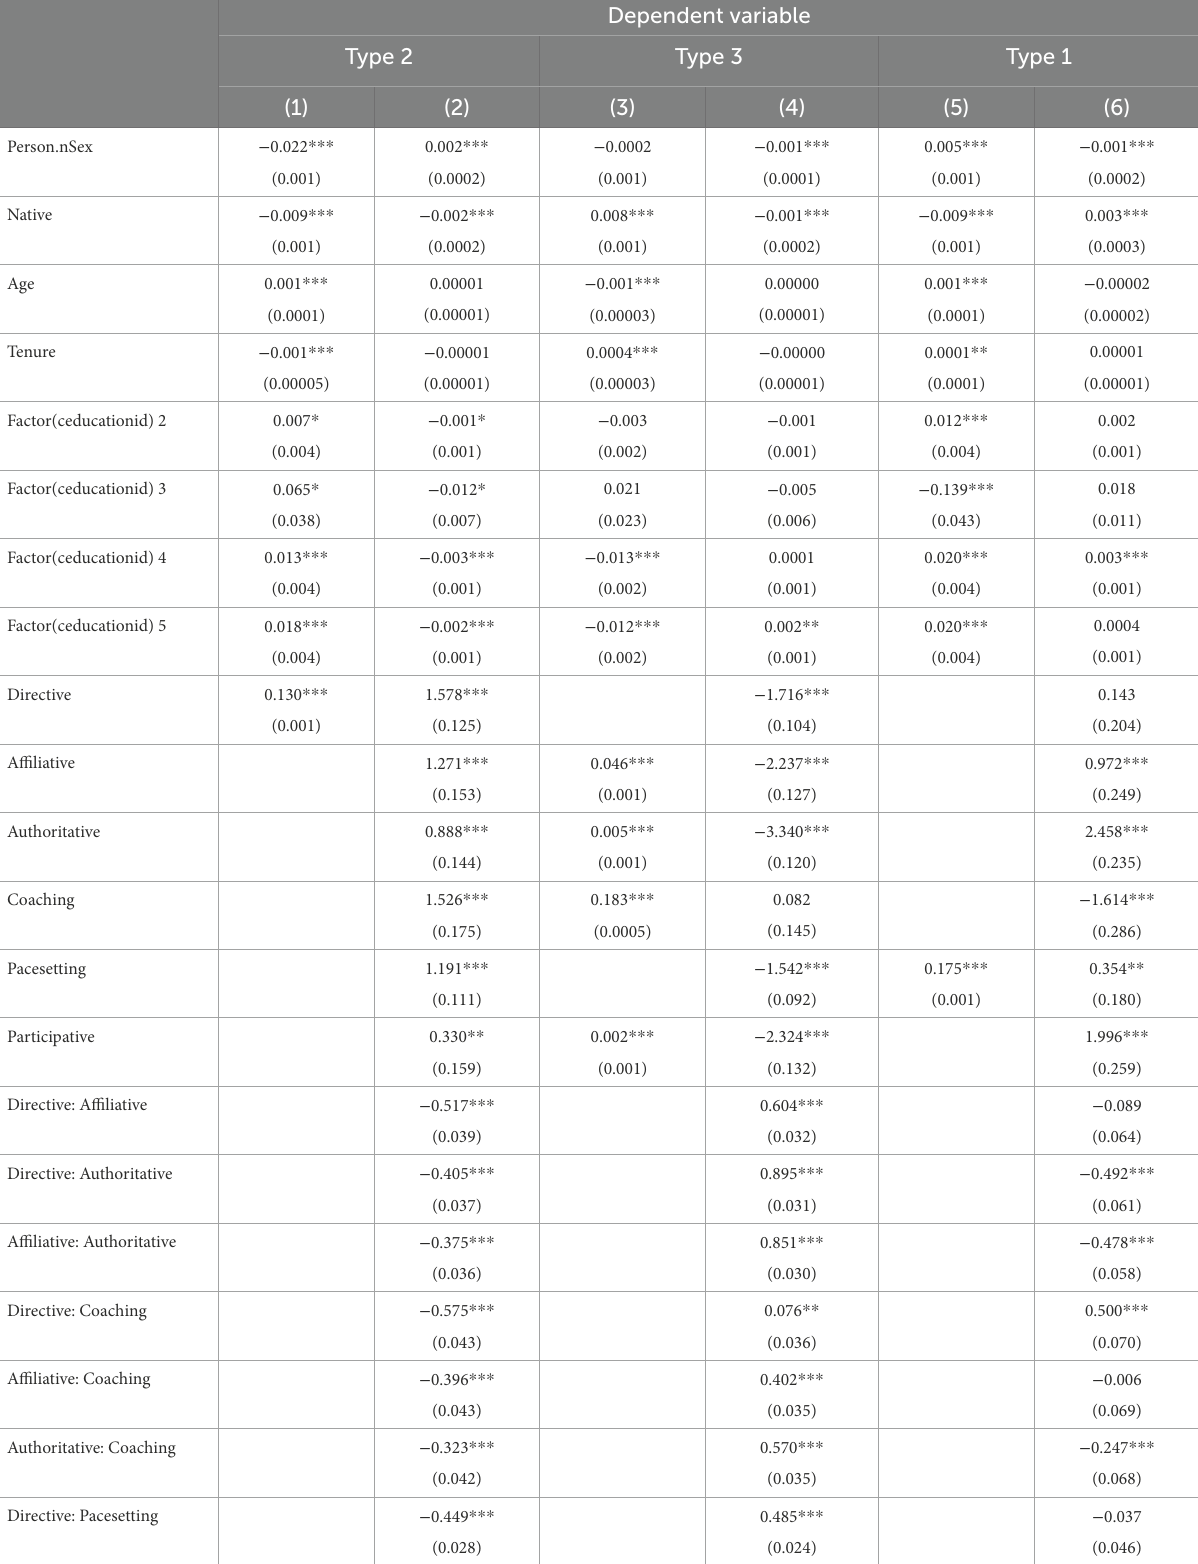
TABLE 4 Regression analyses for the three archetypes as a function of the six (interacted) leadership